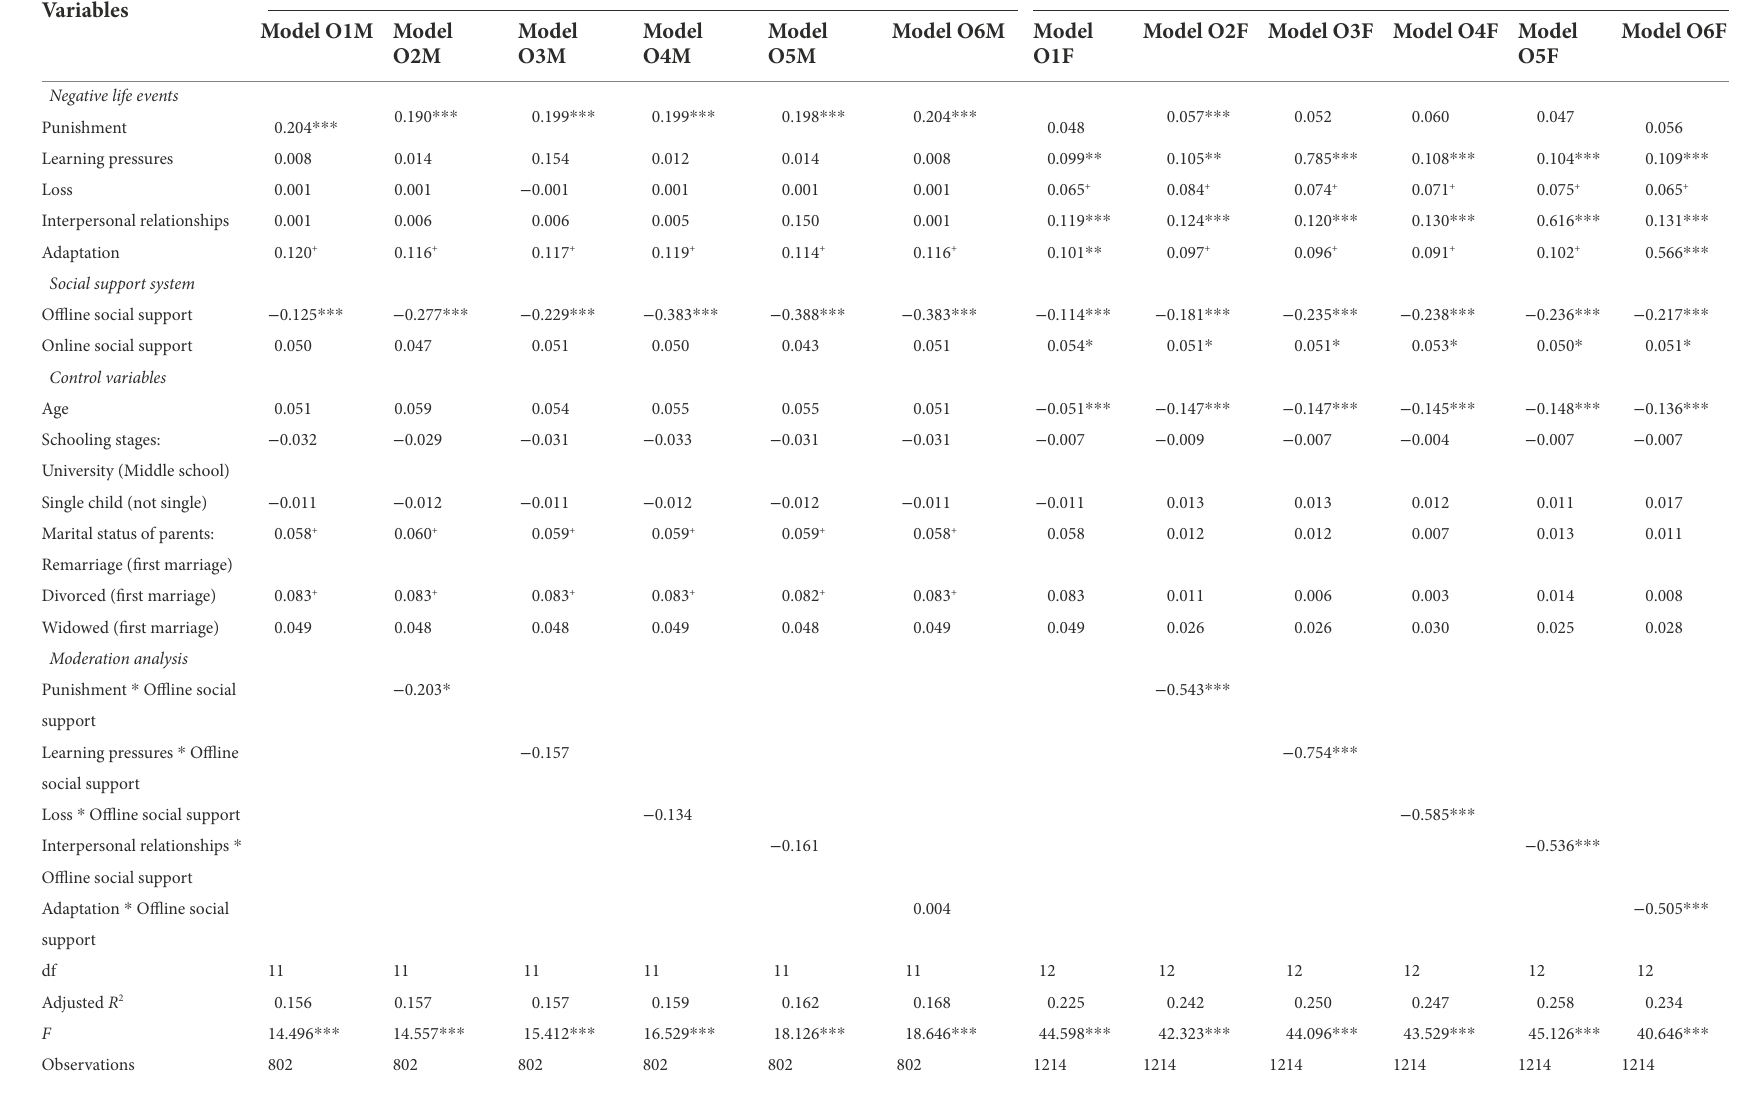
TABLE 3 The direct and moderating effects of offline social support on suicidal ideation among male and female youth. Independent